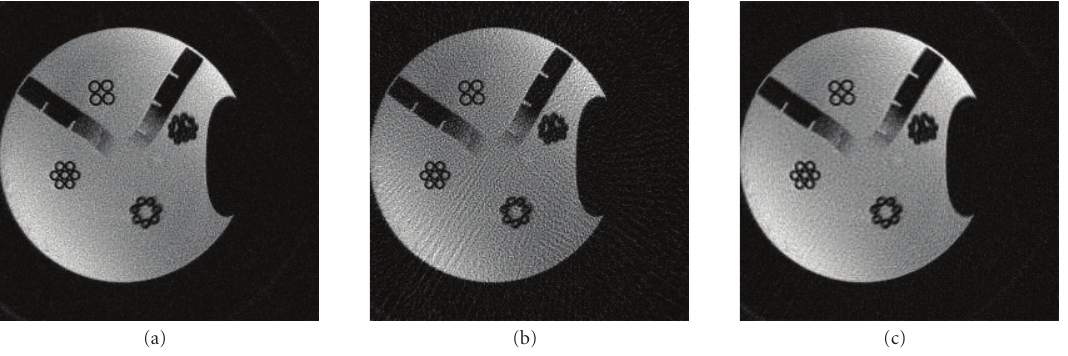
Figure 9: Reconstruction results of well-sampled and undersampled radial scans. (a) 800 rays, direct reconstruction; (b) 200 rays, direct reconstruction; (c) 200 rays, leakage reduction